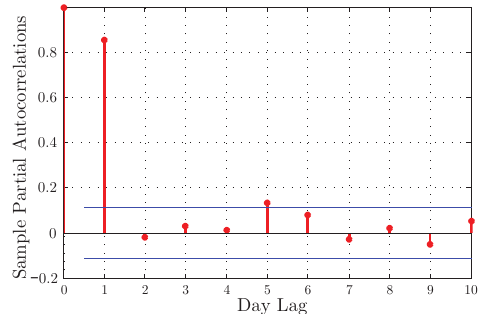
Figure 6: Partial autocorrelation function The ANN architecture used in this study is a three- layer FFNN composed of one input layer, one output layer and one hidden layer, with LevenbergMarquardt learning algorithm. In the hidden layer and output layer tansig (sigmoidal) and linear (purelin) activation functions are used. During the application study many different values of hidden neurons were examined us- ing trial and error method, and the best results are achieved with one hidden layer with 10 neurons.